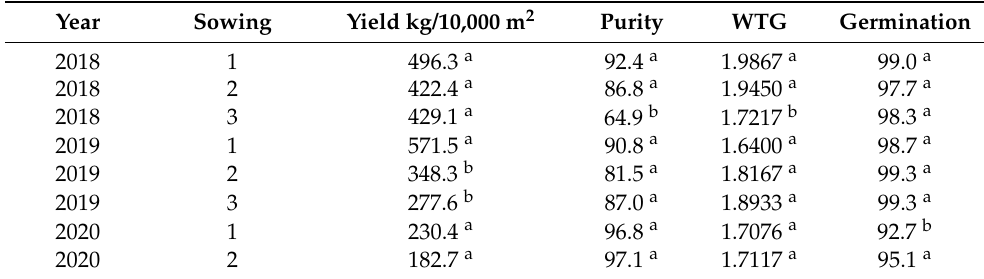
Table 4. Effect of sowing date on yield